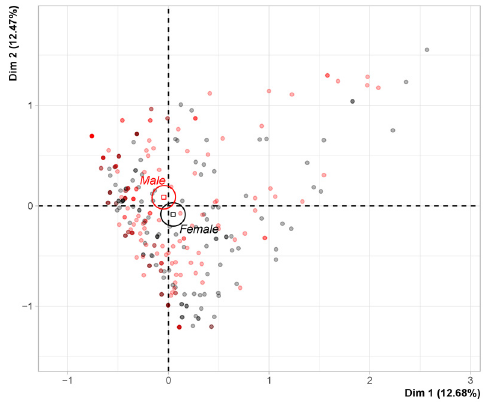
Figure A11. MCA. Distribution of respondents by gender.